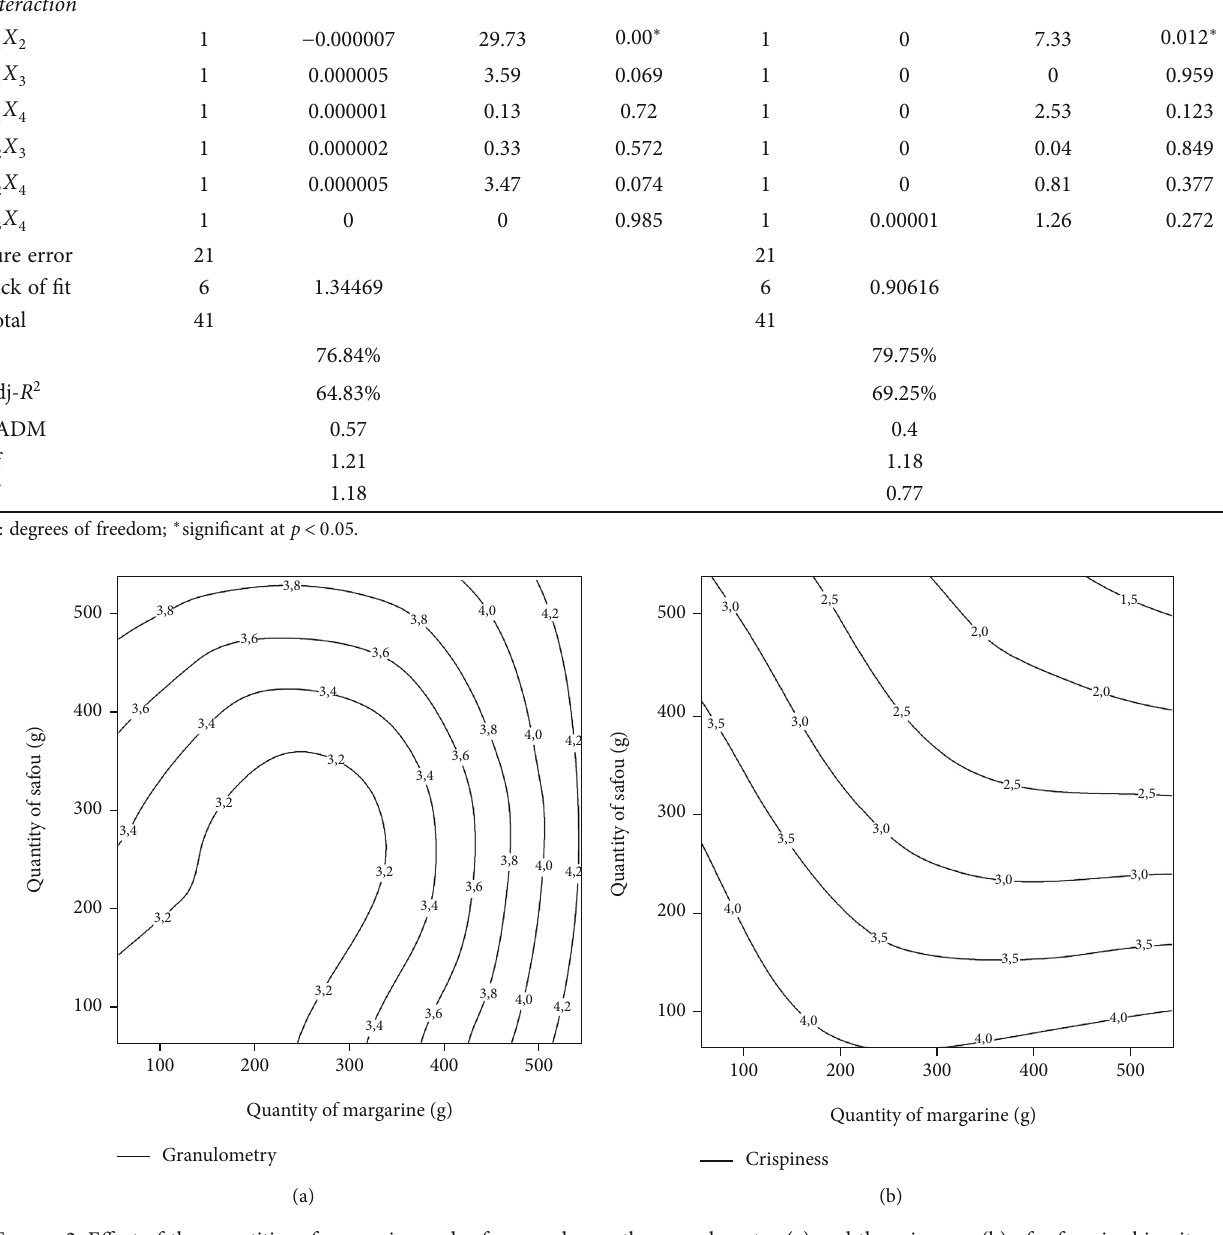
Figure 2: E ff ect of the quantities of margarine and safou powder on the granulometry (a) and the crispness (b) of safou rice